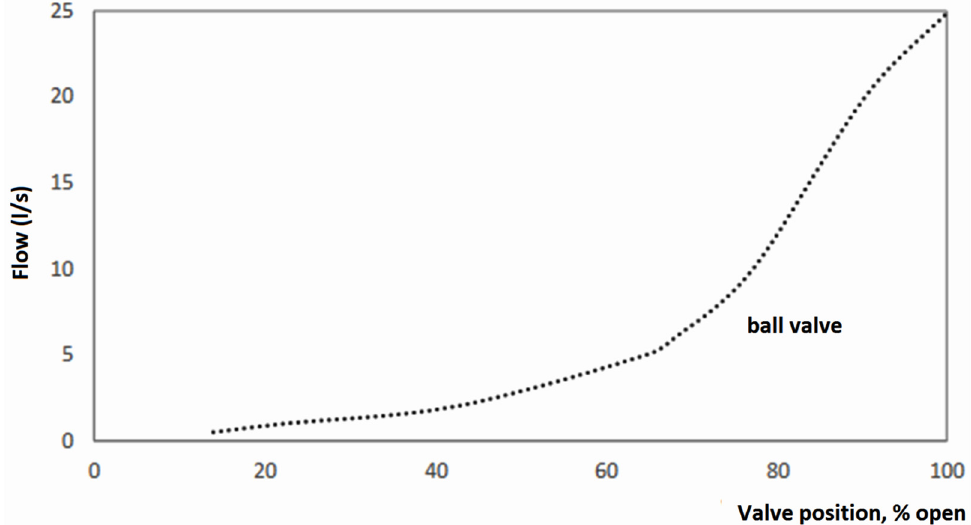
Figure 13. Characteristic curve of the ball